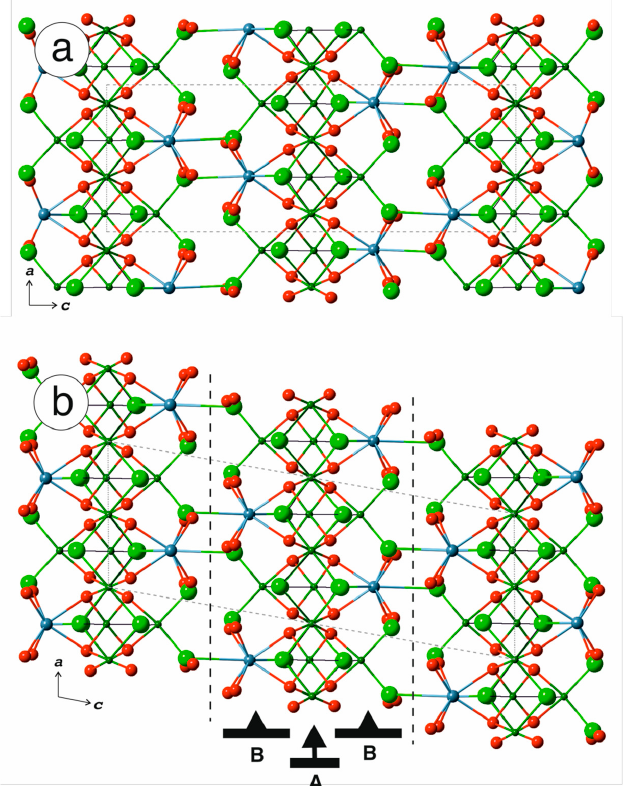
Figure 5. The layer built by Cu 2+ -centered polyhedra with different labeling of Cu sites for dioskouriite-2 M ( a ) and dioskouriite-2 O ( b ). Legend: Cu, Cl, O and Ca atoms are shown as small green, large green, red and blue spheres, respectively; the Cu − Cl bonds shorter and longer than 2.5 Å are shown as dual-band cylinders and black lines, respectively.